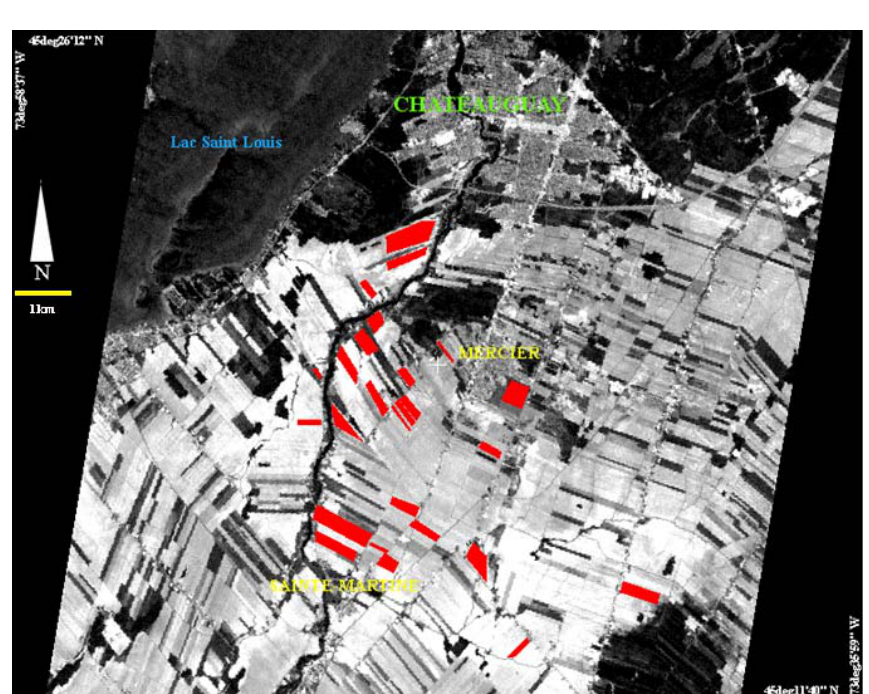
Fig. 2. Location of the parcels (Airborne photography over Chateauguay watershed).